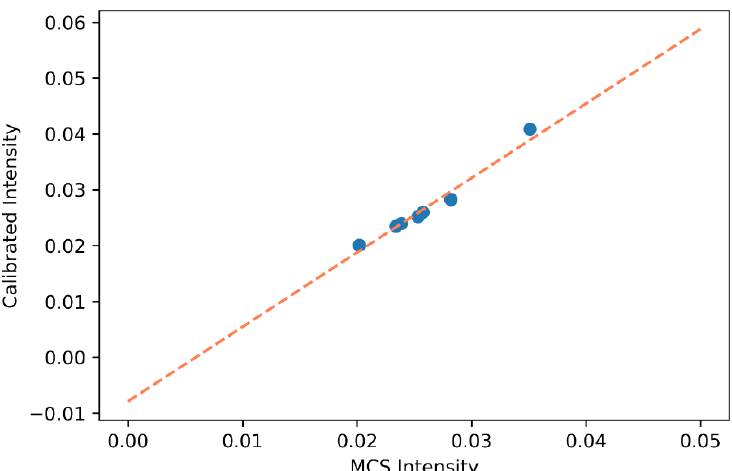
Figure 11. Fitted scatter plot of the calibration of the public dataset and MC photon intensity.